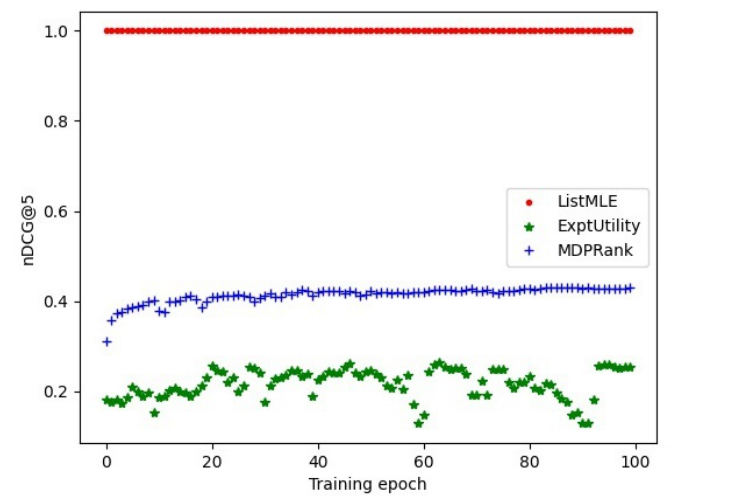
Figure 1. The quality of sampled